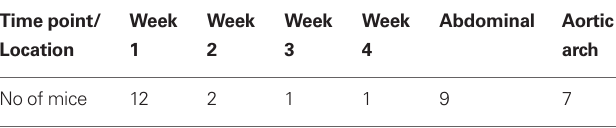
Table 3 | Timing and site-specificity of Ang II-induced aortic